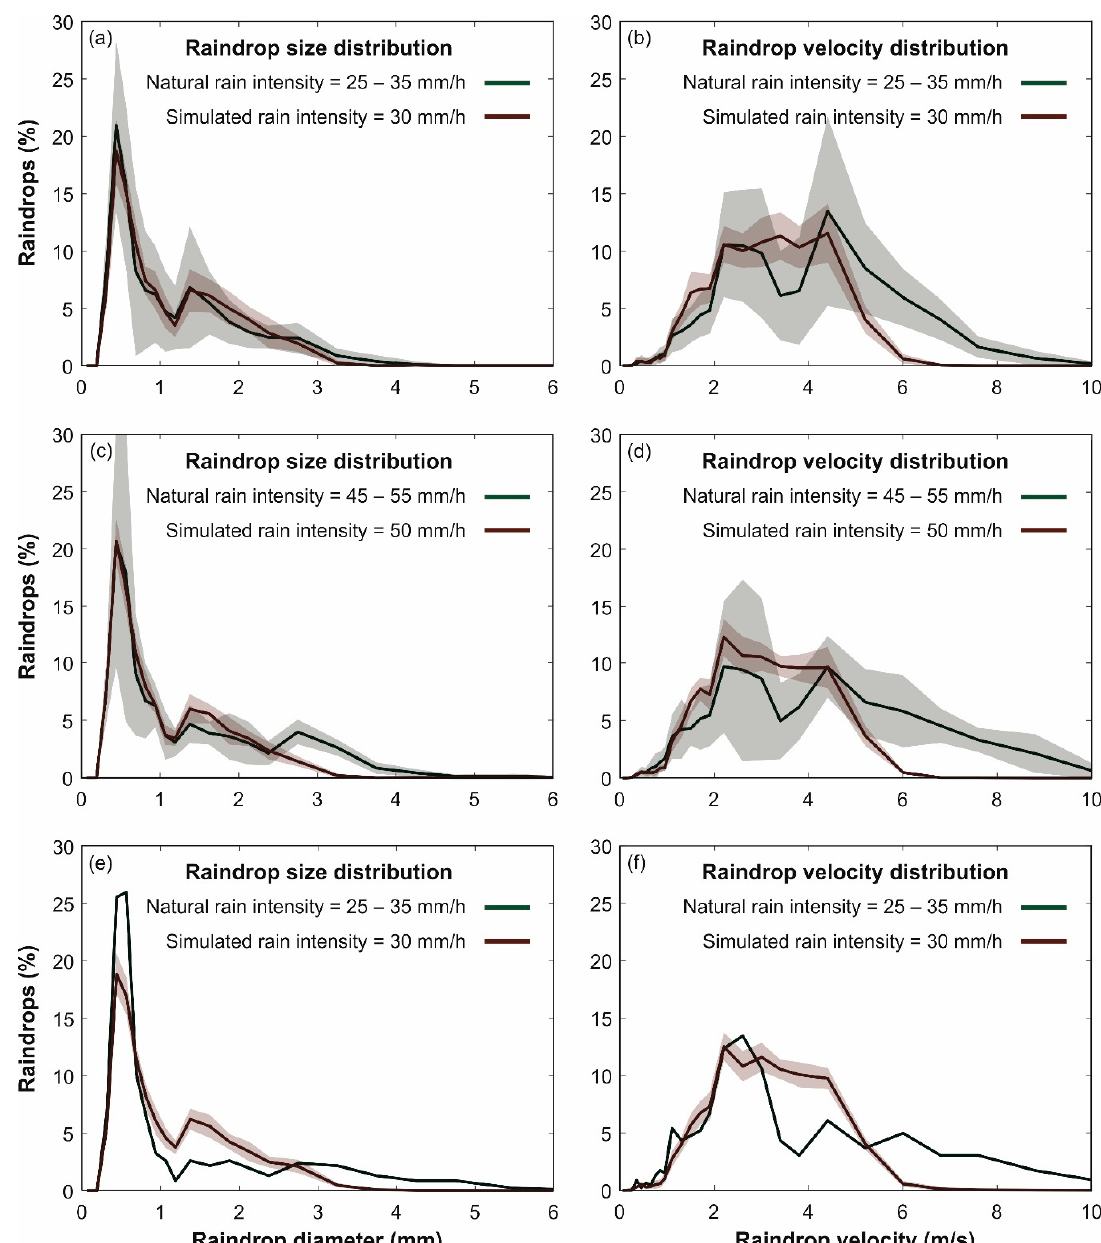
Figure 8. Comparison of mean distributions of raindrop sizes ( plots a, c and e ) and velocities ( plots b, d and f ) between natural (green) and simulated (red) rainfall measurements for the three rain intensities that the rainfall simulator can generate. Contours represent standard deviation of disdrometer measurements both for natural and simulated rain.